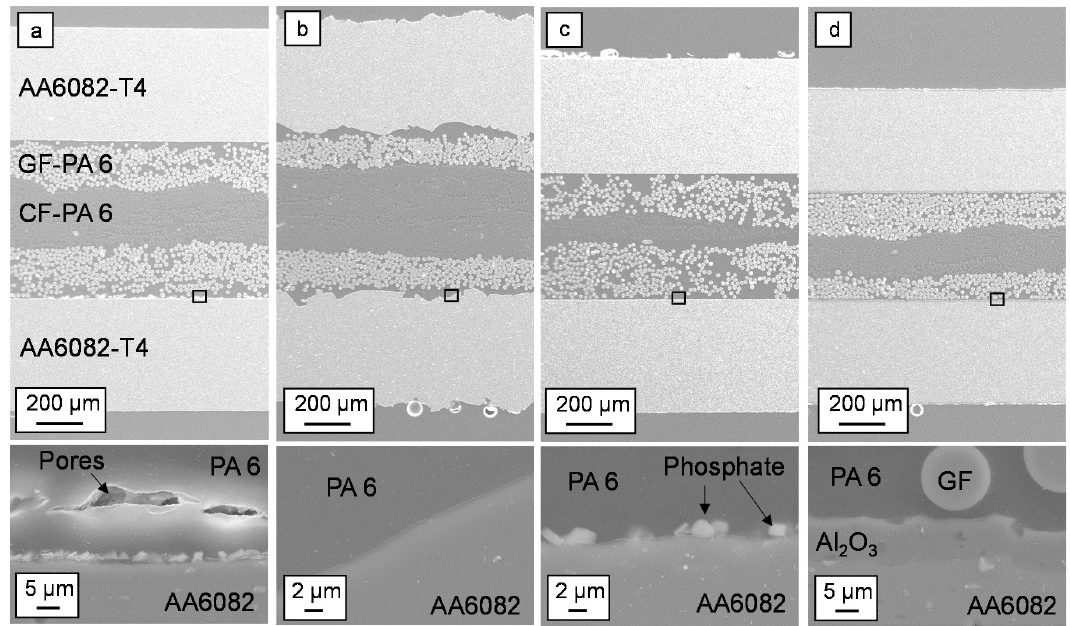
Figure 5. Scanning electron microscope cross-sections of hybrid laminates with an ( a ) adhesion promoted, ( b ) mechanically blasted, ( c ) phosphated, and ( d ) anodized aluminum alloy AA6082-T4 and a graded structure of glass and carbon fiber-reinforced polyamide 6 (PA 6) in a 2/1 configuration, below: detailed area of the interface.